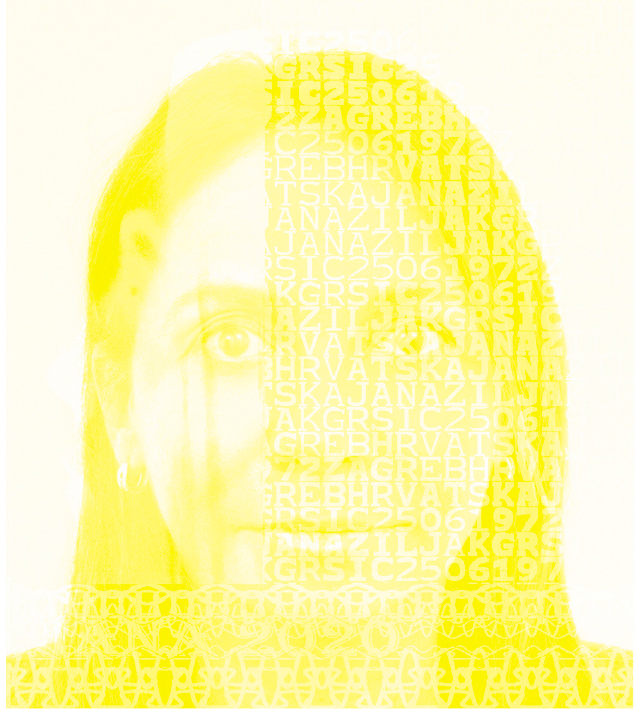
Figure 12. Yellow channel (Y). The final, hierarchical graphic and print is a simulation of the color portrait (Figure 4), while the other images (Figures 5–7) are hidden within that portrait. The portrait, after the four images have been merged, is given in a C, M, Y, K,